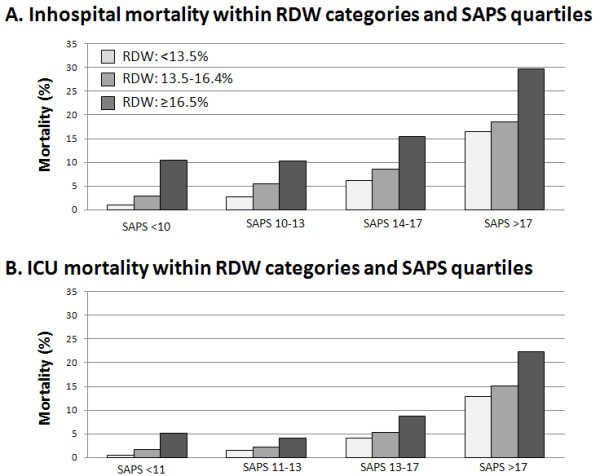
RDW categories (< 13.5%, 13.5% to 16.4%, ≥16.5%) and mortality within SAPS subgroups.